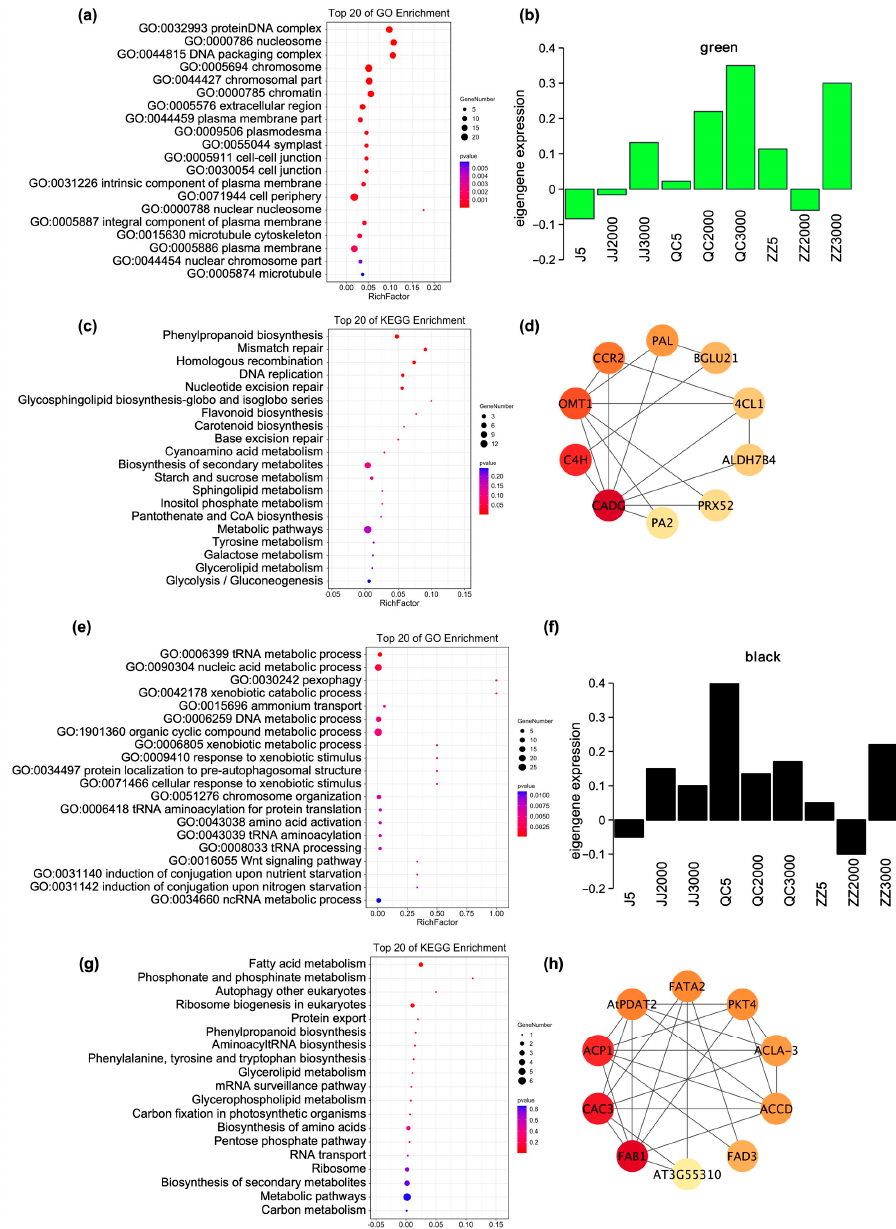
Figure 6. ( a ) Gene ontology and ( c ) Kyoto Encyclopedia of Genes and Genomes (KEGG) enrichment analyses of module green. ( e ) Gene ontology and ( g ) Kyoto Encyclopedia of Genes and Genomes (KEGG) enrichment analyses of module black; Expression profile and transcriptional regulatory network associated with the tissue-specific modules. ( b ) Module green and ( f ) module black show the consensus expression pattern of the co-expressed genes in each module. Note: JJ5: grafted seedlings propagated from 5-year-old donors, JJ2000: grafted seedlings propagated from 2000-year-old donors, JJ3000: grafted seedlings propagated from 3000-year-old donors; QC5: cutting seedlings propagated from 5-year-old donors, QC2000: cutting seedlings propagated from 2000-year-old donors, QC3000: cutting seedlings propagated from 3000-year-old donors; ZZ5: sown seedlings propagated from 5-year-old donors, ZZ2000: sown seedlings propagated from 2000-year-old donors, and ZZ3000: sown seedlings propagated from 3000-year-old donors. ( d , h ) represent the hub genes in transcriptional regulatory network of module green and module black, respectively. The color from dark to light indicates the Betweenness Centrality value from large to